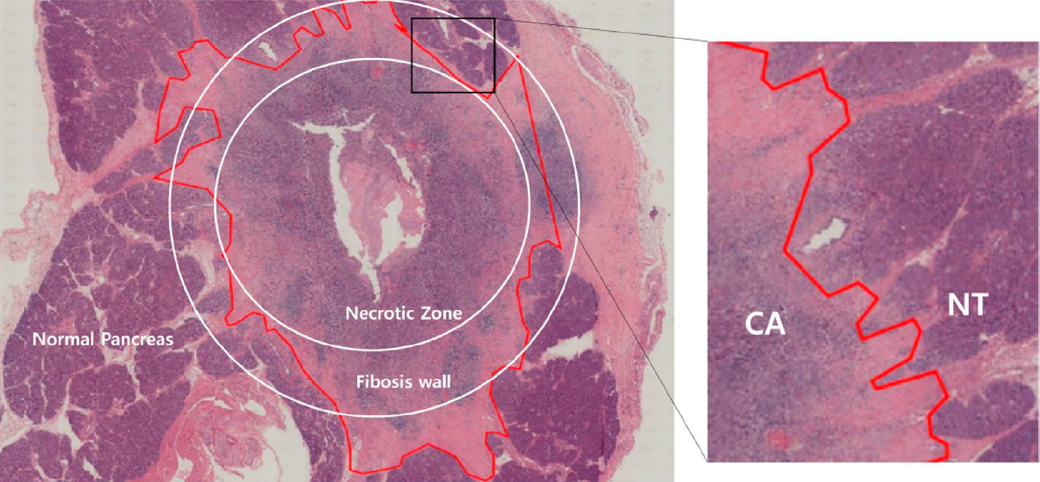
Figure 4. Microscopic examination Histological image of the laser ablation outcome: Untreated parenchyma and ablated tissues were clearly differentiated with coagulated necrosis and fibrous tissue area on H&E-staining. NT: normal tissue, CA: coagulative area (40×).